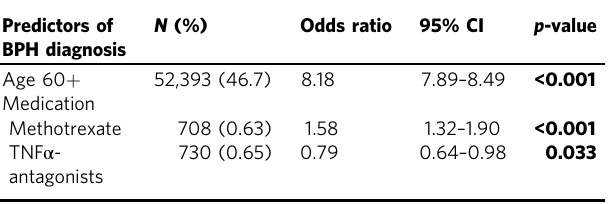
Table 1 Modeling predictors of BPH diagnosis indicate that treatment of patients with TNF-antagonists is protective for